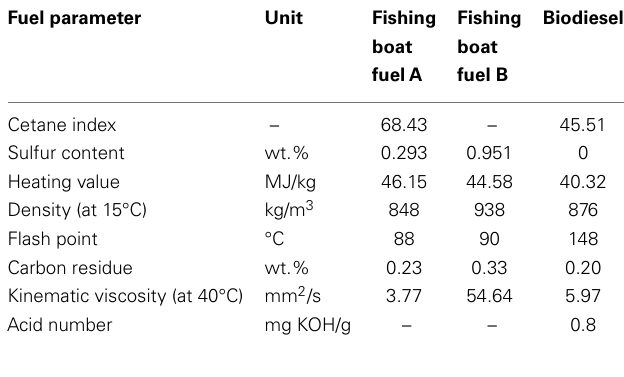
Table 1 | Fuel properties of biodiesel and fishing boat fuelsA and B.